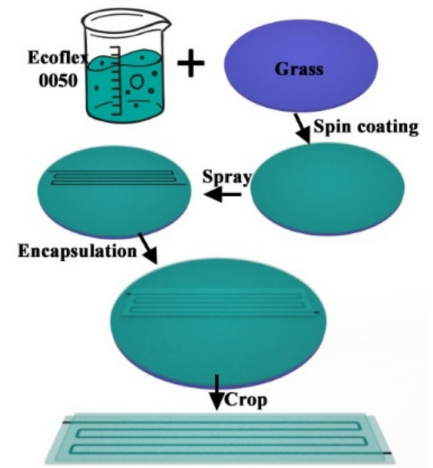
Figure 4. The process of fabricating flexible sensors by spraying.